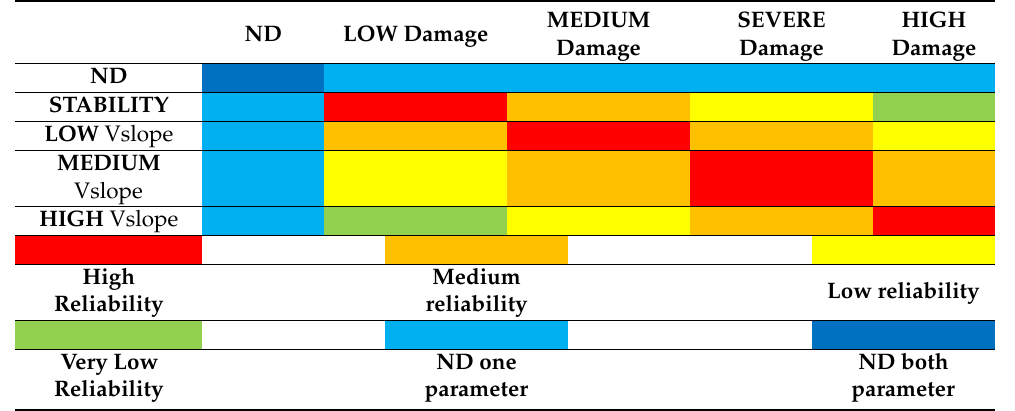
Table 2. Reliability matrix of the relationship between Vslope and damage